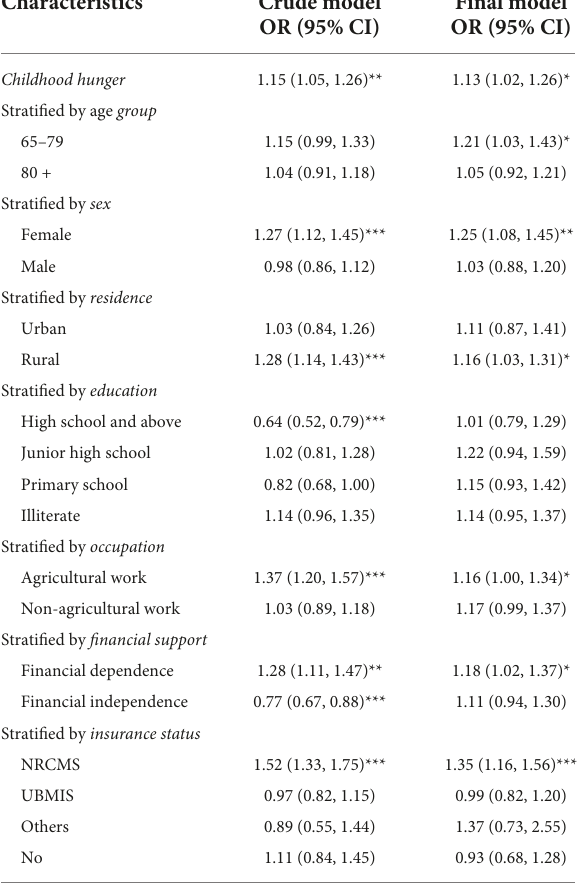
TABLE 3 The association of childhood hunger and frailty stratified by age, sex, residence, socioeconomic status, insurance status. Characteristics